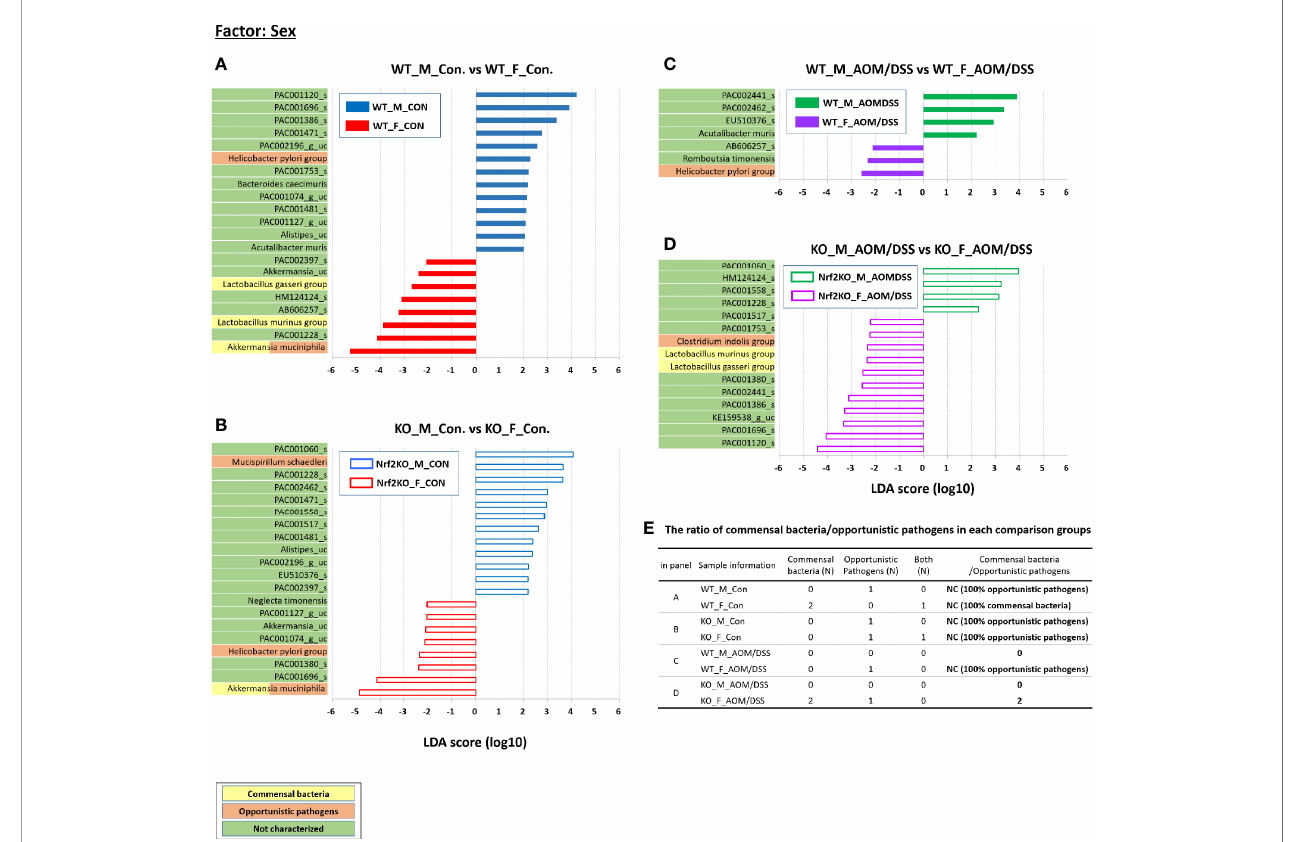
FIGURE 5 | Sex-speci fi c alterations in the abundance of the gut microbiota composition examined using LEfSe. Bar plots of the LEfSe results, which were obtained based on the following criteria: 1) the alpha value for the factorial Kruskal – Wallis H test between assigned taxa when compared with that of the groups < 0.05; 2) the alpha value for the pairwise Wilcoxon test among the taxonomic compositions < 0.05; 3) the threshold of the logarithmic LDA score for discriminative features < 2.0; 4) a multi-class analysis set as all-against-all; the LEfSe plot was further simpli fi ed; 5) overlapping bacteria selection; 6) identi fi cation and classi fi cation of the bacterial characteristics based on previous reports as “ commensal bacteria, ” “ opportunistic pathogens, ” and “ not characterized; ” and 7) removal of non-overlapping bacteria only at “ not characterized ” microbiome. In the LEfSe plot, all commensal bacteria and opportunistic pathogens and only overlapped “ not characterized ” bacteria are included. Bar plots at the species level with signi fi cant differences in abundance based on LEfSe. The color bars and lines show the LDA scores of species that enriched in indicated condition; (A) blue bar (WT male controls), (A) red bar (WT female controls), (B) blue line (Nrf2 KO male controls), (B) red line (Nrf2 KO female controls), (C) green bar (WT male AOM/DSS-induced CRC), (C) purple bar (WT female AOM/DSS-induced CRC), (D) green line (Nrf2 KO male AOM/DSS-induced CRC), and (D) purple line (Nrf2 KO female AOM/DSS-induced CRC). Each color on the species name indicates the characteristics of each genus: yellow for commensal bacteria, orange for opportunistic pathogens, and green for not characterized bacteria. The p -values were determined using the non-parametric factorial Kruskal – Wallis sum-rank test. (E) The ratio of commensal bacteria to opportunistic pathogens based on the LEfSe results in each comparison group. LDA, linear discriminant analysis; LEfSe, LDA effect size; CRC, colorectal cancer; WT, wild-type; KO, Nrf2 knockout; Con, control; AOM, azoxymethane; DSS, dextran sodium sulfate; M, male; F, female; N, number; NC, not